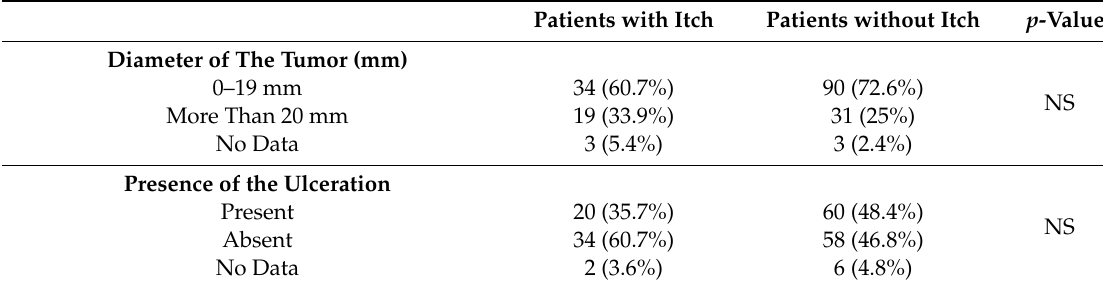
Table 1. Cont. Patients with Itch Patients without Itch p -Value